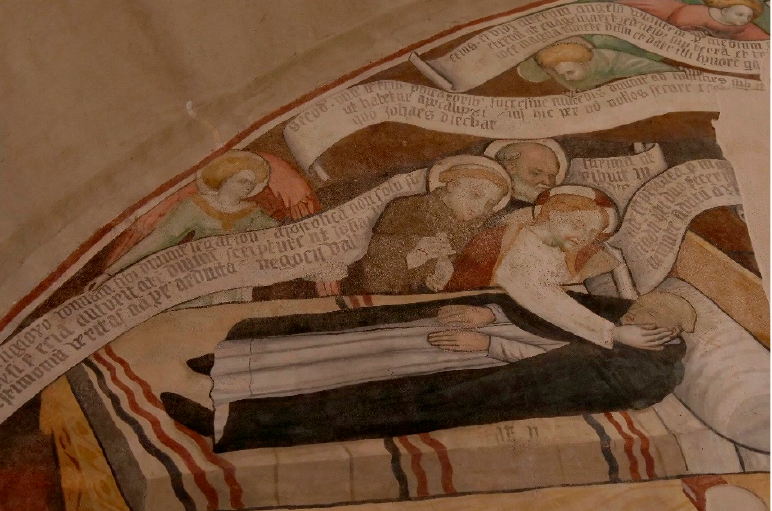
Figure 6. Vincent Ferrer’s vision. Santa Maria Assunta Parish Church (Macello, Piedmont). Aymo Duce, circa 1429 (photograph courtesy of Leonardo Guazzo).